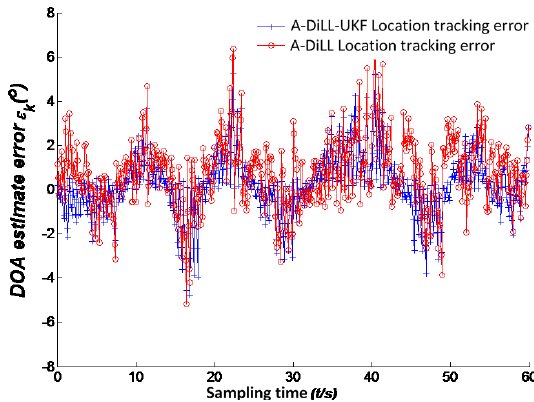
Figure 6. Estimated error of DOA.